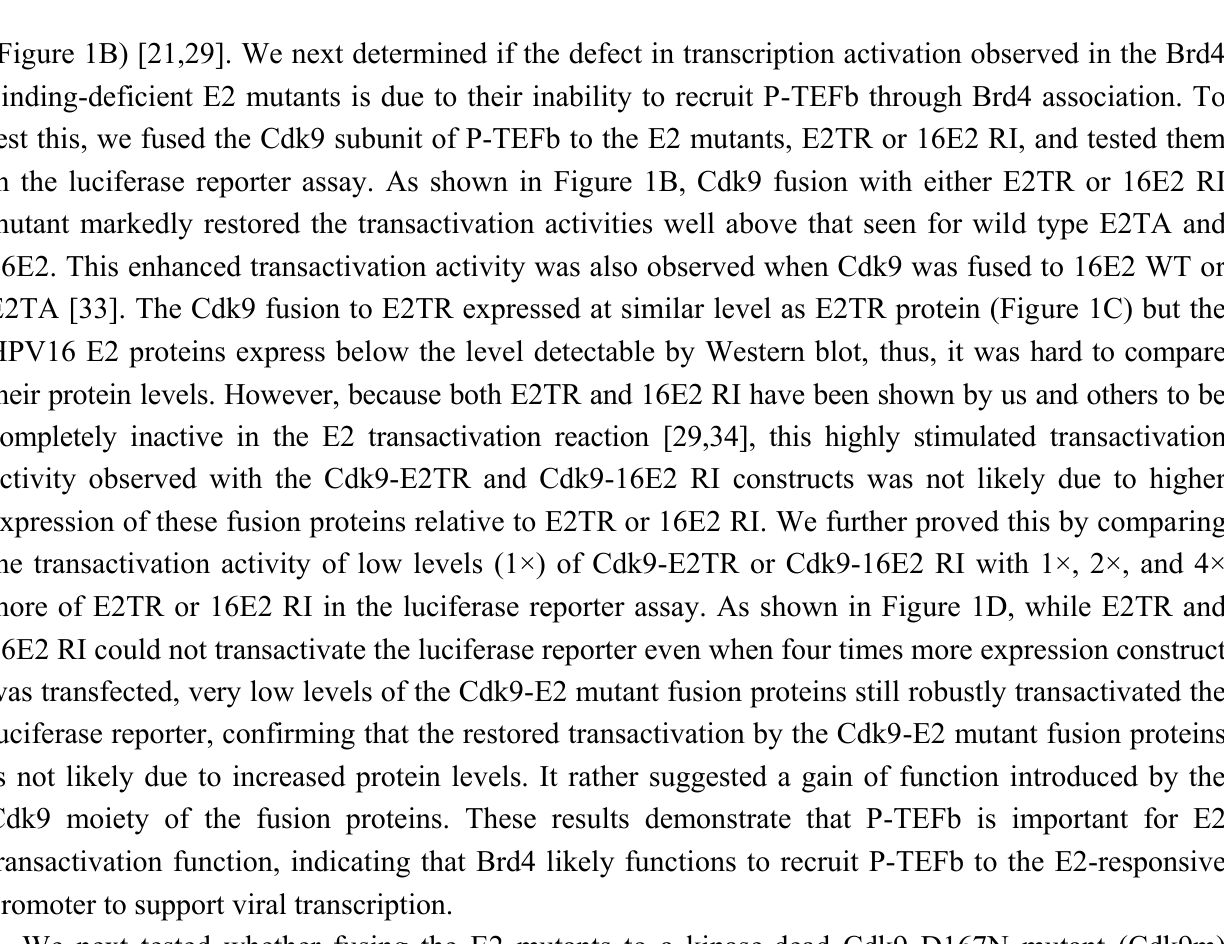
Figure 1. P-TEFb is important for E2-mediated papillomavirus transcription activation. ( A ) Schematic diagram of the 2x2xE2BS-Luciferase reporter. Two pairs of E2